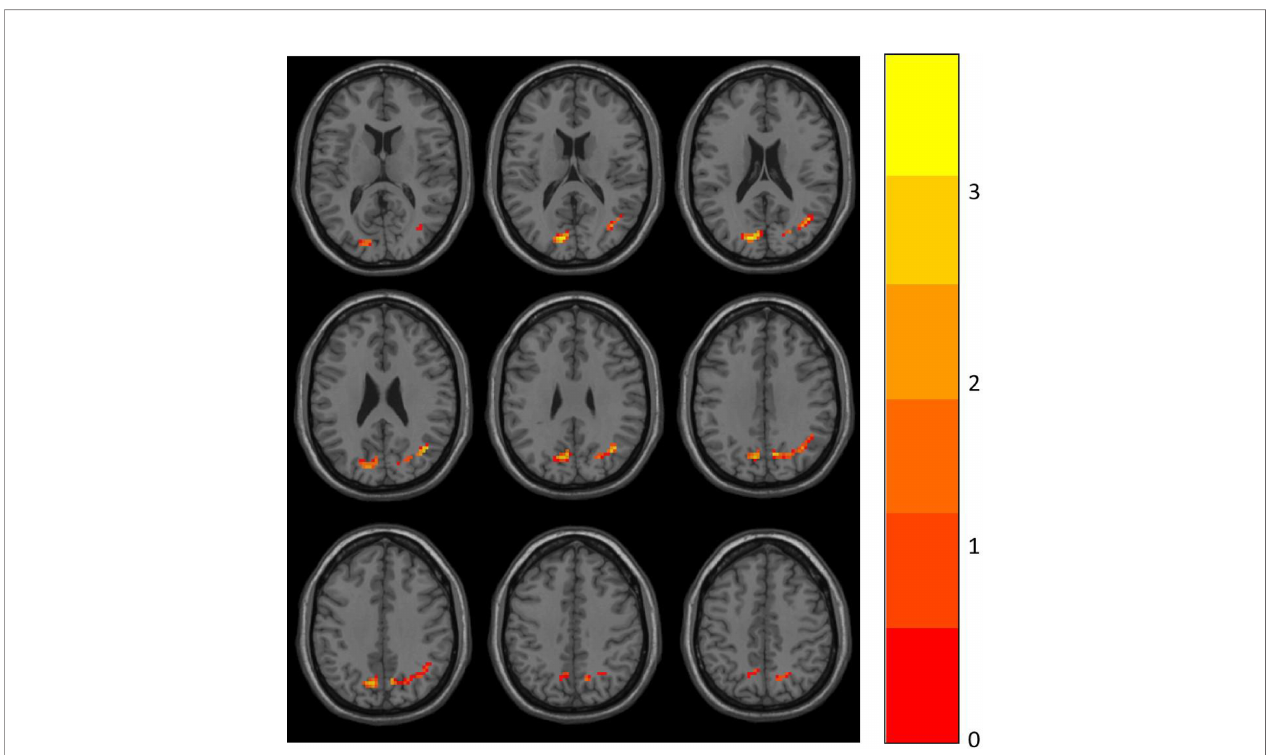
FIGURE 1 | ALFF differences between the HD and CN group. The differences map at the given threshold ( p <0.001, cluster size>119 voxels, Gaussian random fi eld corrected) was shown. Blue indicates HD individuals had decreased ALFF compared with controls and the red indicates the opposite.